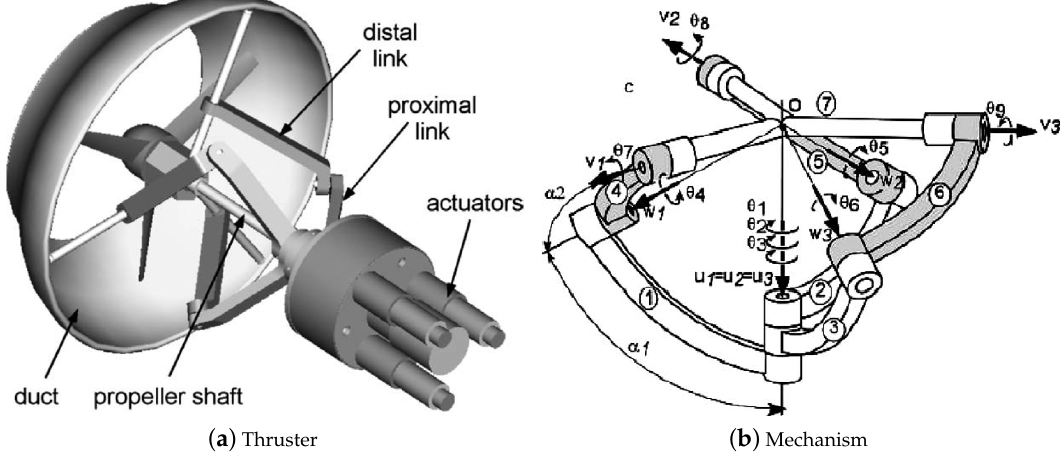
Figure 7. A spherical full parallel mechanism with 3-DOF for the duct and propeller reconfiguration [27].